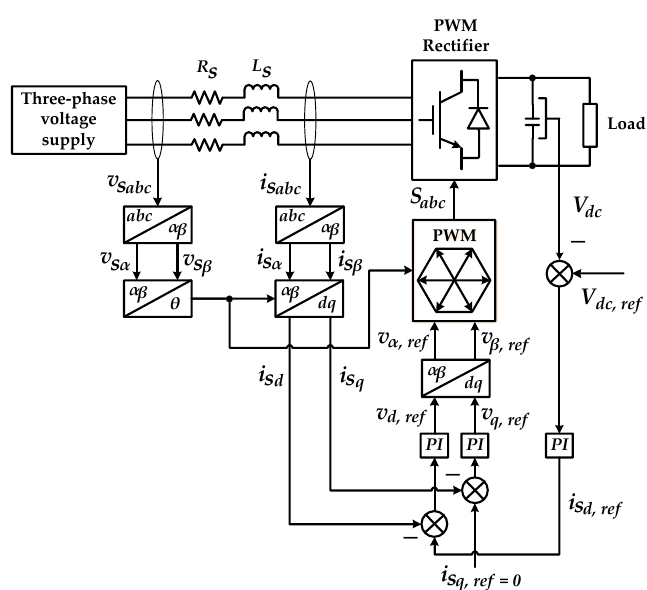
Figure 2. Overall control structure of voltage-oriented control of a pulse-width modulation (PWM) rectifier [24].